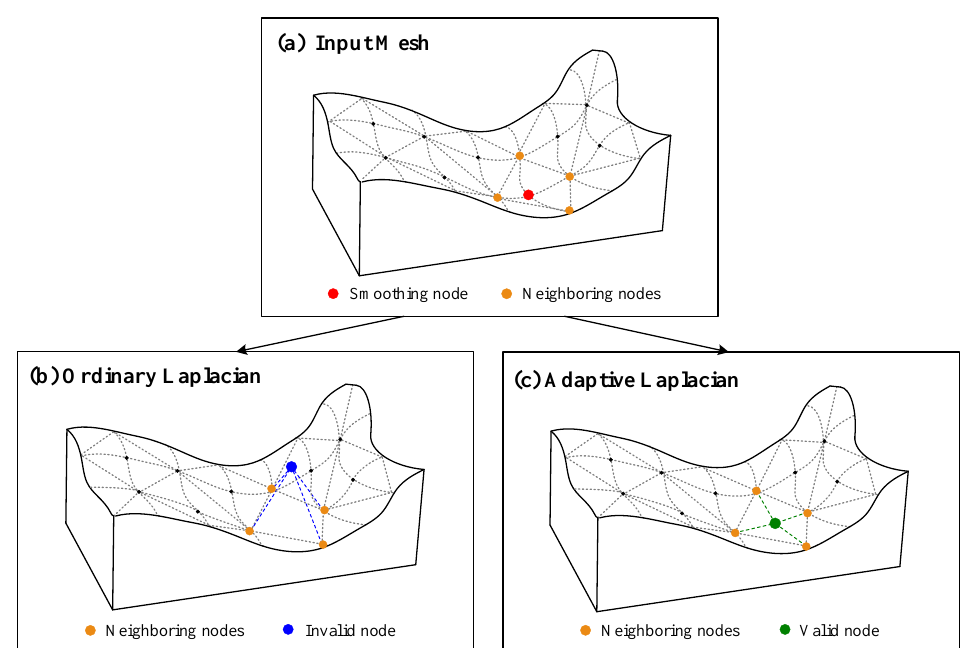
Figure 2. An illustration for comparing the smoothed positions of a sample node in the concave area of a tetrahedral mesh when using ordinary Laplacian mesh smoothing and adaptive Laplacian mesh smoothing. ( a ) Input mesh; ( b ) mesh after ordinary Laplacian smoothing; ( c ) mesh after adaptive Laplacian